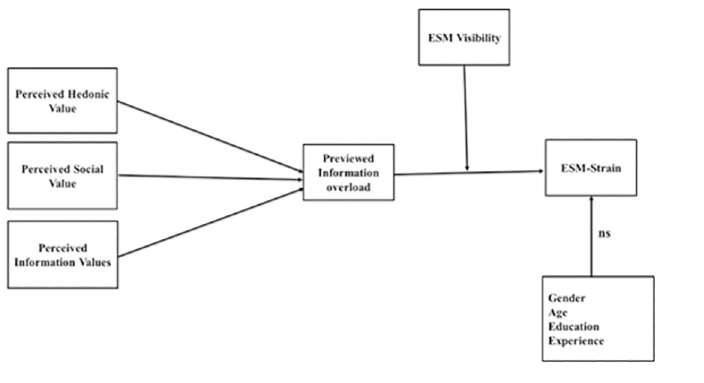
Fig 1. Conceptual